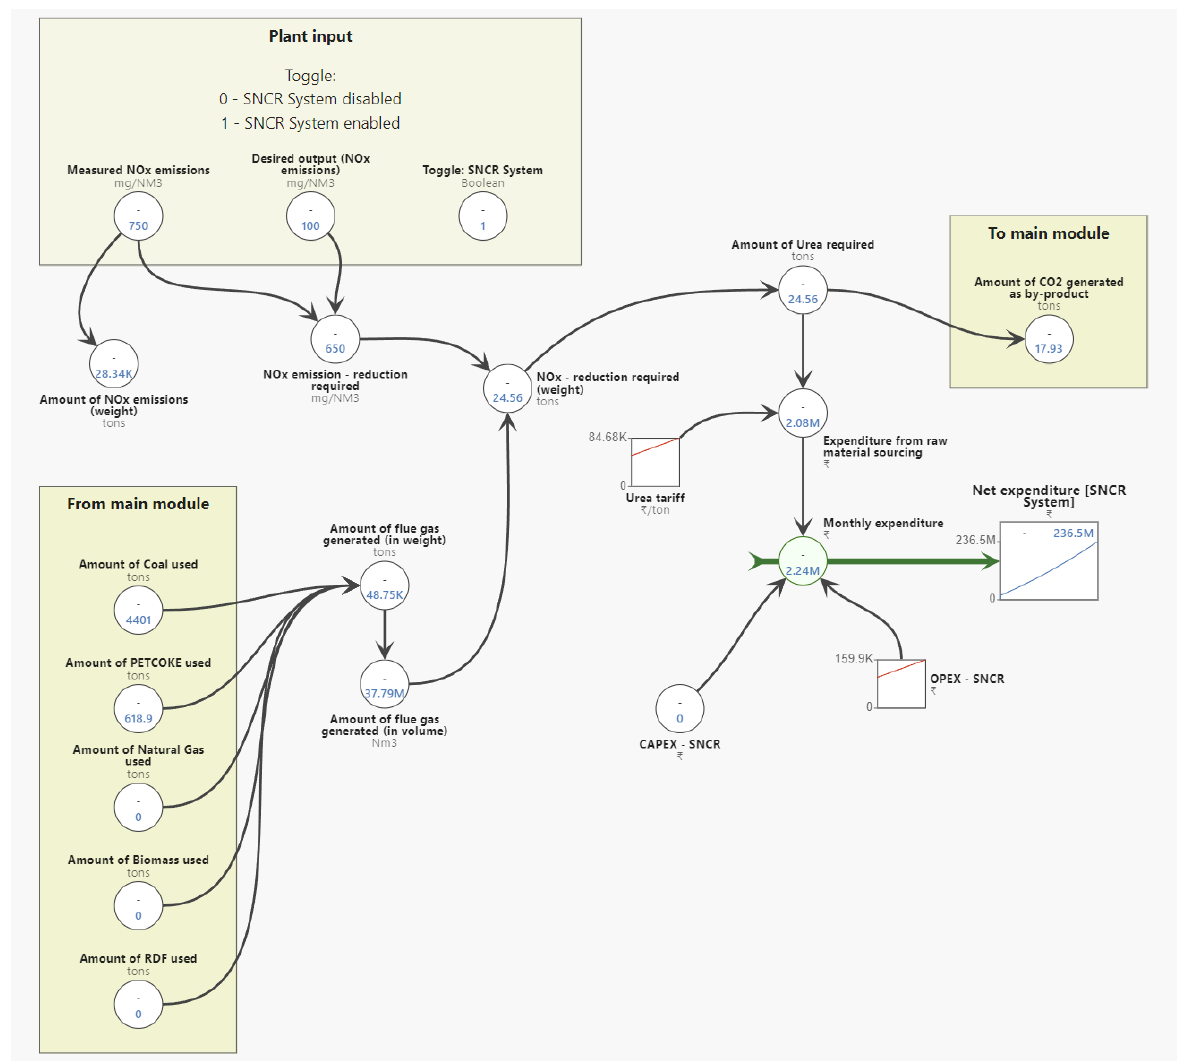
Figure A2. Stock-and-flow diagram of the selective non-catalytic reduction system. Table A3. Description of the variables used in the SNCR Module.